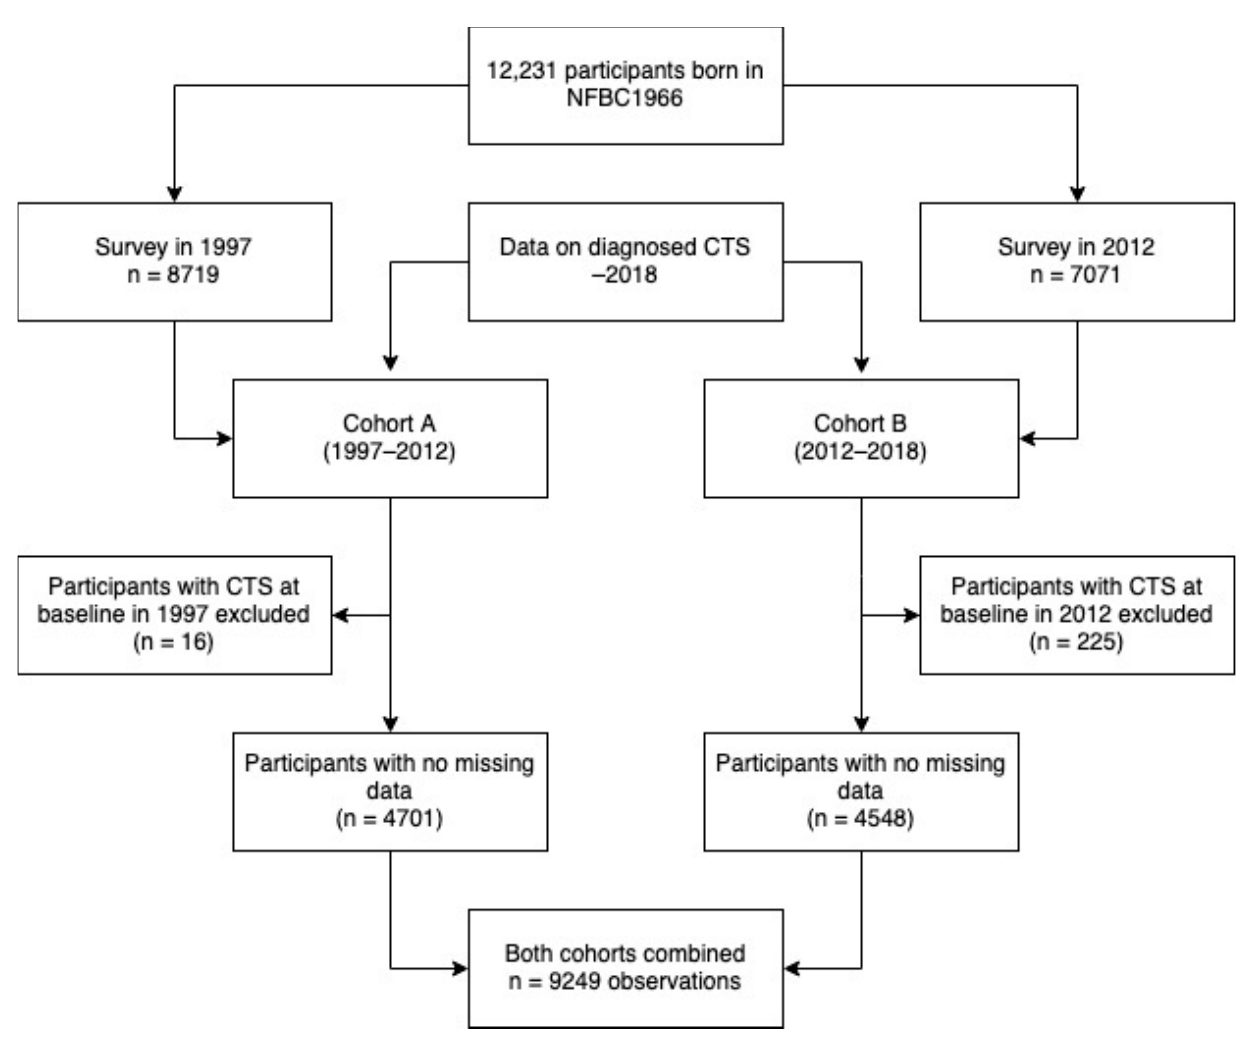
Figure 1. Flowchart of NFBC1966 study population.